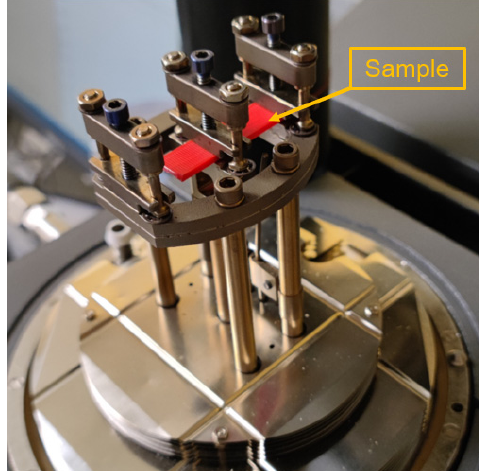
Figure 4. DMA test setup.